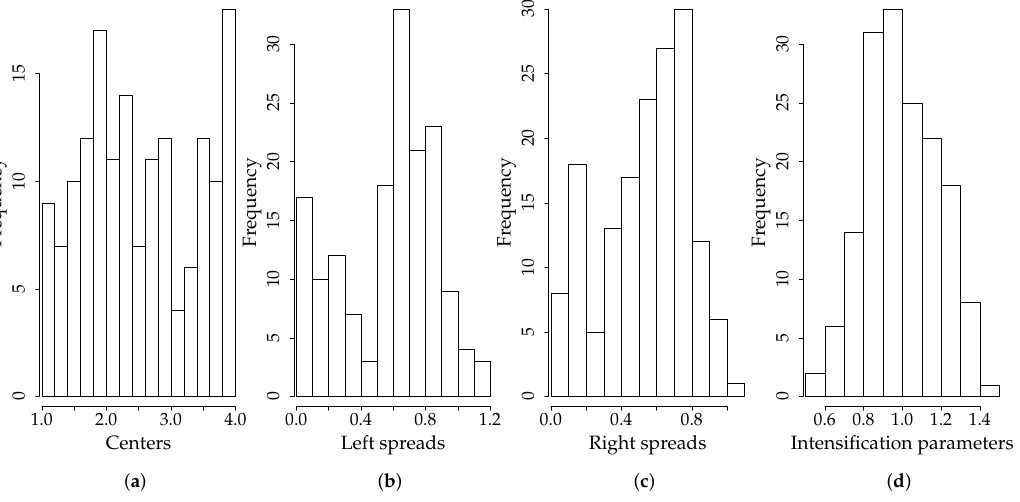
Figure 3. Application : Histograms of the parameters of composite fuzzy indicator depression . (a) : Figure 4. Application: Histograms of the parameters of composite fuzzy indicator depression . Histogram of the centers c i distribution; (b) : Histogram of left spreads ( c i l i ) distribution; (c) : ( a ) Histogram of the centers c i distribution; ( b ) histogram of left spreads ( c i l i ) distribution; ( c ) his- − − Histogram of right spreads ( r i c i ) distribution; (d) : Histogram of intensification parameters ( ω i ) togram of right spreads ( r i c i ) distribution; ( d ) histogram of intensification parameters ( ω i ) distri- − − distribution. Note that the intensification parameter shows a concentration closed to one. bution. Note that the intensification parameter shows a concentration closed to